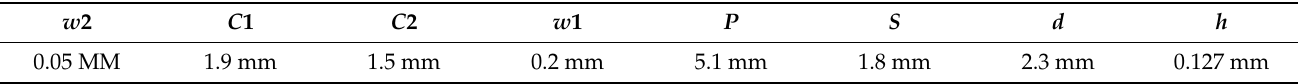
Table 1. Design parameters for the proposed